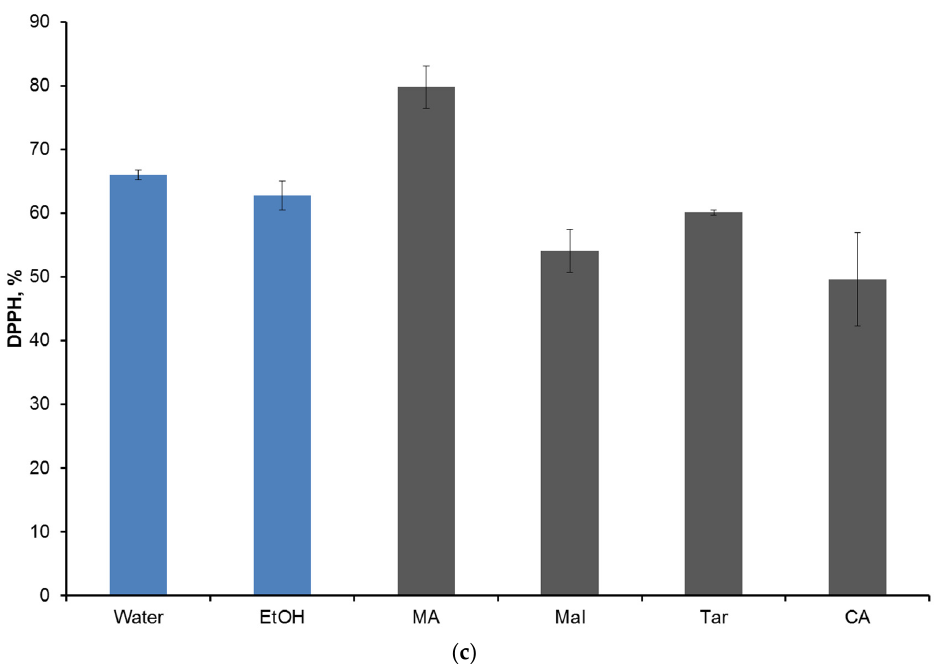
Figure 2. Comparison of the efficiency of various solvents in terms of TPC ( a ), TAC ( b ) and DPPH ( c ) at 45 °C for 60 min. Blue color is used for reference solvents.